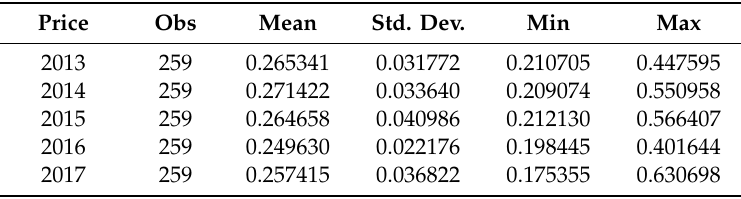
Table 5. Evolution of the electricity price for households ( € /